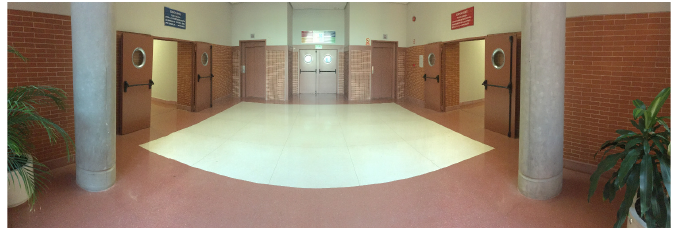
Figure 8. Real Test Bed: Indoor scenario (Robot point of